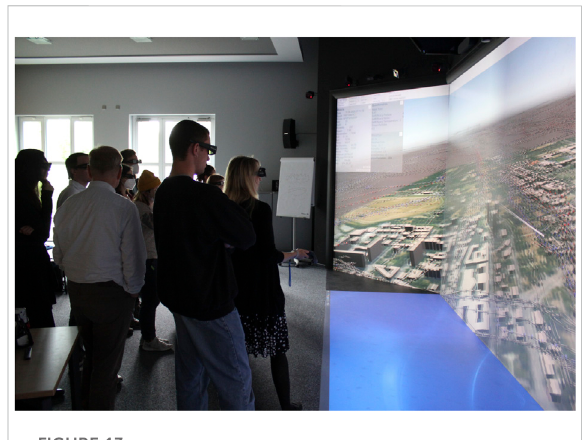
FIGURE 13 Presentation of the visualization and analysis application during a workshop with stakeholders in the VR environment TESSIN VisLab (Photos: Özgür Ozan